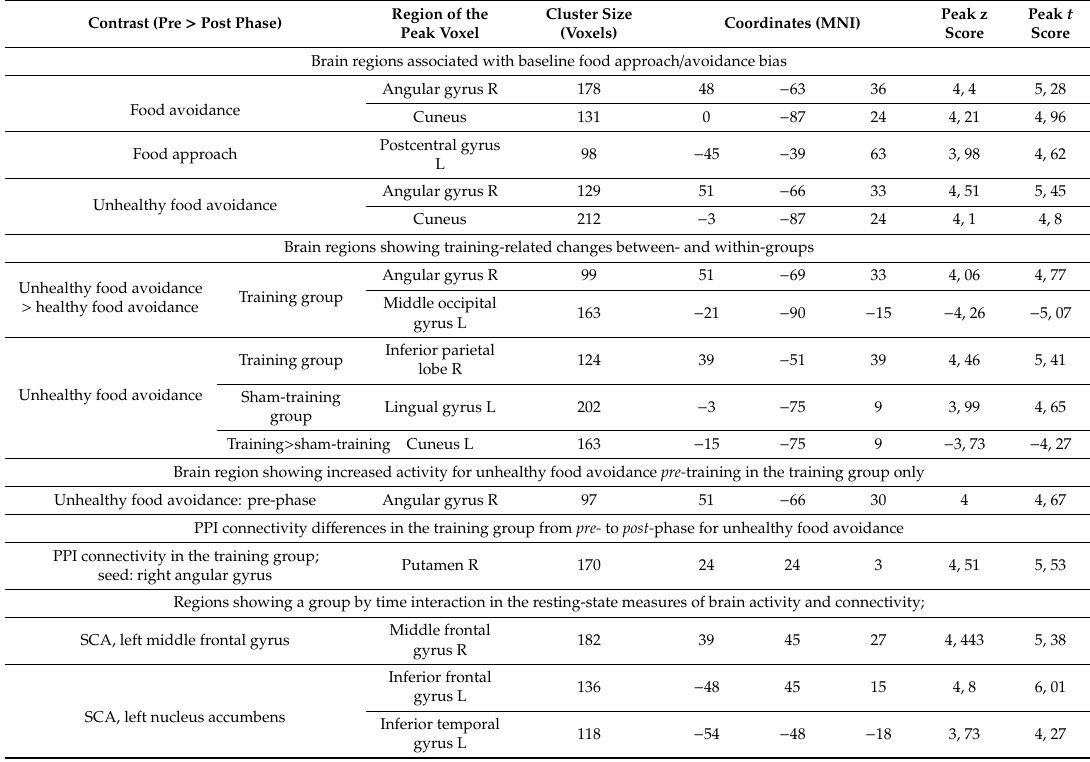
Table 3. Brain regions showing training-related changes between- and within-groups. Contrast (Pre > Post Phase) Region of the Peak Voxel